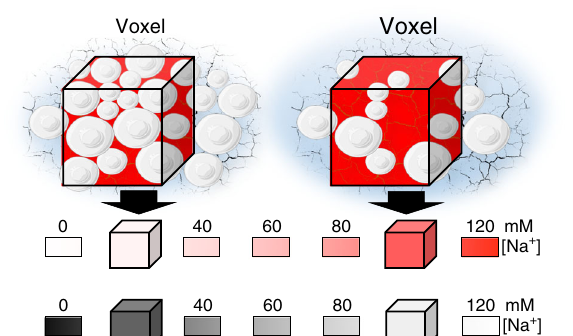
Fig. 1 Histochemical impact of tissue architecture. Intracellular compartments are rich in K + (yellow), while extracellular compartments in Na + (red); in both, the sum of K + and Na + concentrations ([K + ] and [Na + ], respectively) is similar. When intracellular and extracellular compartments are mixed, i.e. a whole tissue chemical analysis is performed, total [Na + ] is higher in any tissue with physiologically less intracellular volume or undergoing loss of cellularity or oedema accumulation compared to a reference tissue. The concept applies to 23 Na-MRI (bottom), where the average signal from a voxel is presented as a shade of colour, typically grey in the commonly used radiological black – white lookup table. ECV extracellular volume, ICV intracellular